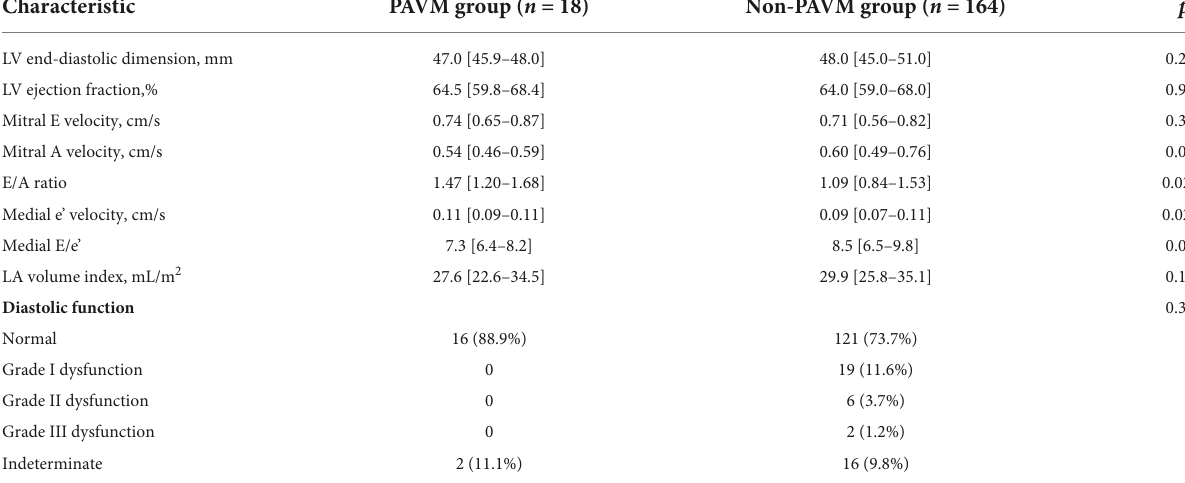
TABLE 2 Transthoracic echocardiography